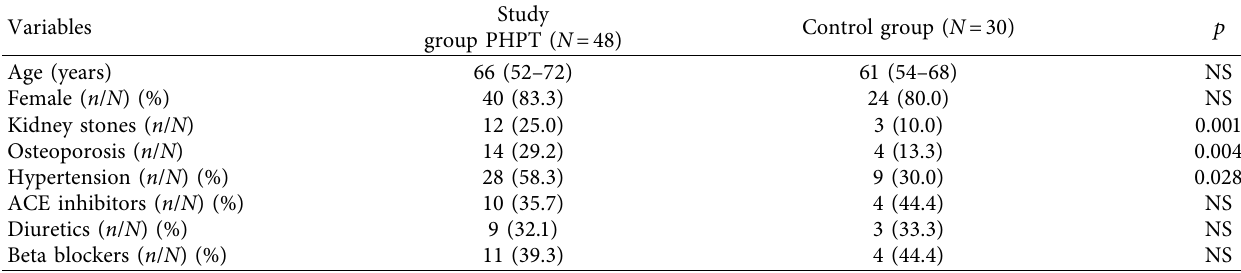
Table 1: Clinical diferences between the study and control group.